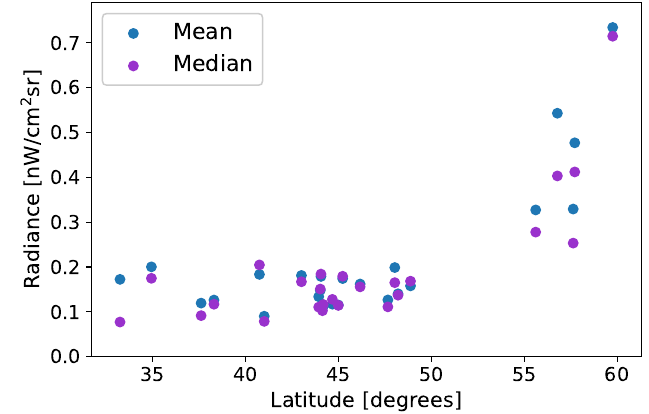
Figure 4. Typical monthly variation in observed radiance for each of the classes. In each case, W c /2 is shown in dark blue, and the sample standard deviation σ in light blue. The left plot includes data from all months, the right plot includes data only from the autumn months.